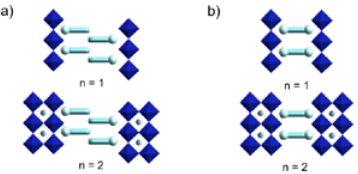
Figure 4. Structural representation of layered two-dimensional per- ovskites. Schematic of (a) S 2 A n–1 Pb n I 3n+1 (Ruddlesden-Popper, RP), (b) SA n–1 Pb n I 3n+1 (Dion Jacobson, DJ) formulations with different number of inorganic layers (n). Blue octahedra illustrate the {PbI 64– } units, light blue spheres the A cations, whereas the cyan and green rods correspond to the organic spacers (S,